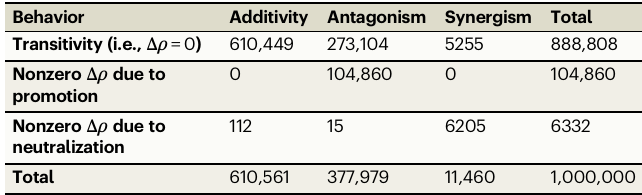
Table 2 | Cross-occurrences of non-transitivity during anti- biotic sequences and non-additivity during antibiotic combi- nations in 1,000,000 random